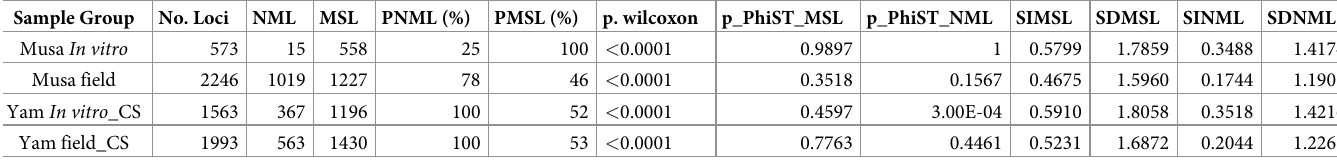
Table 4. MSAP profile summary for Musa and Yam.